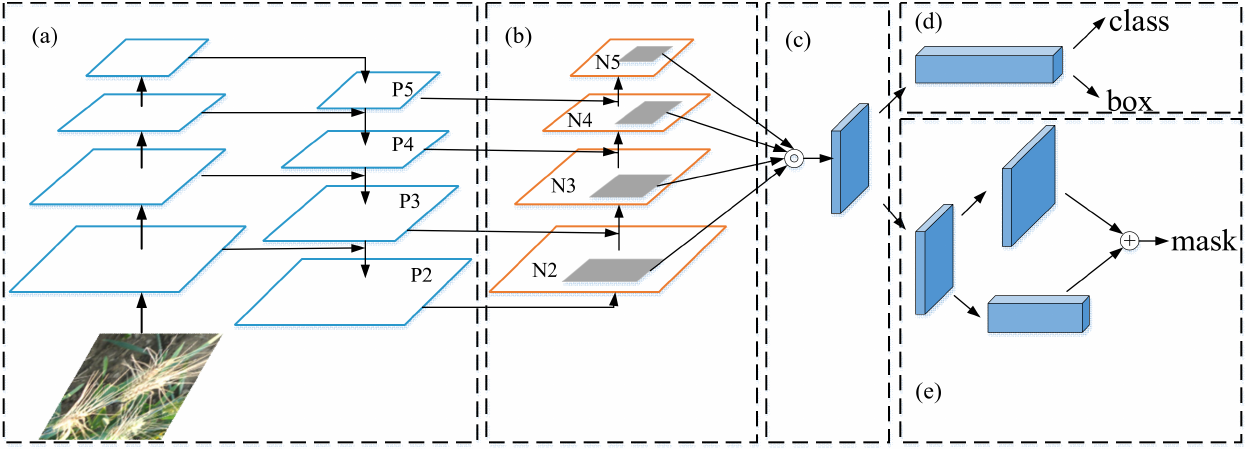
Figure 7. The structure of bneck.